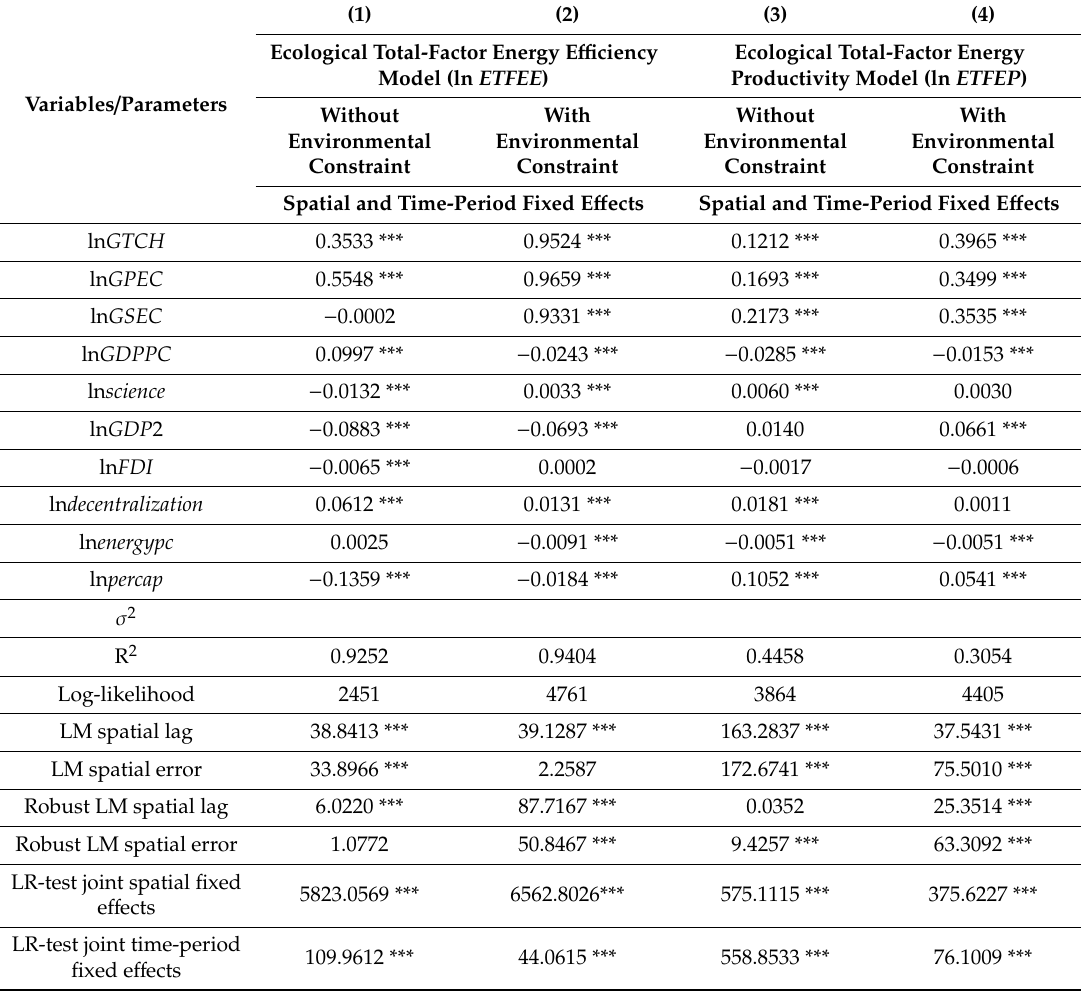
Table 2. Estimation results of non-spatial panel